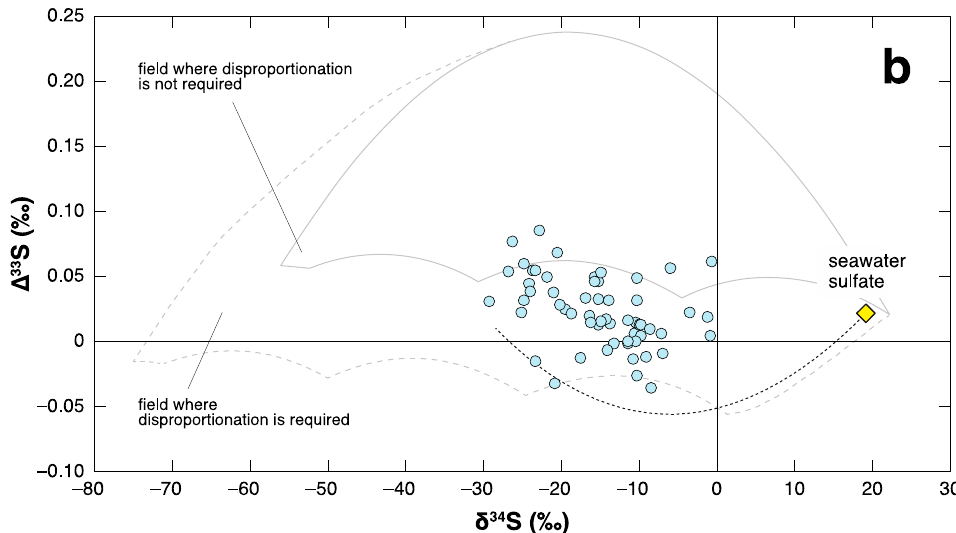
Figure 8. Multiple sulfur isotope record across the P-TB at Opal Creek [67]. ( a ) sulfur isotope chemostratigraphy. A red line represents the extinction horizon [105]; ( b ) δ 34 S– ∆ 33 S cross plot. The estimated δ 34 S and ∆ 33 S values of contemporaneous seawater sulfate are from Wu et al. [68]. A possible mixing curve is after Zhang et al. [67].